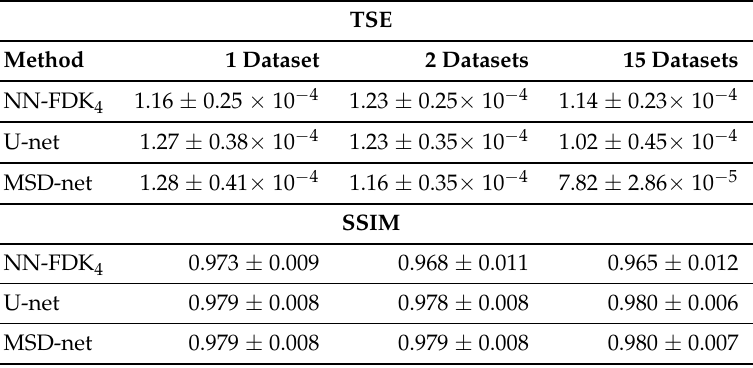
Table 7. Average and standard deviation of the quantitative measures computed over 6 walnuts for various training scenarios. The datasets are low-dose and have N a = 500 projection angles. The NN-FDK reconstruction time is 4-10 times lower than U-net and